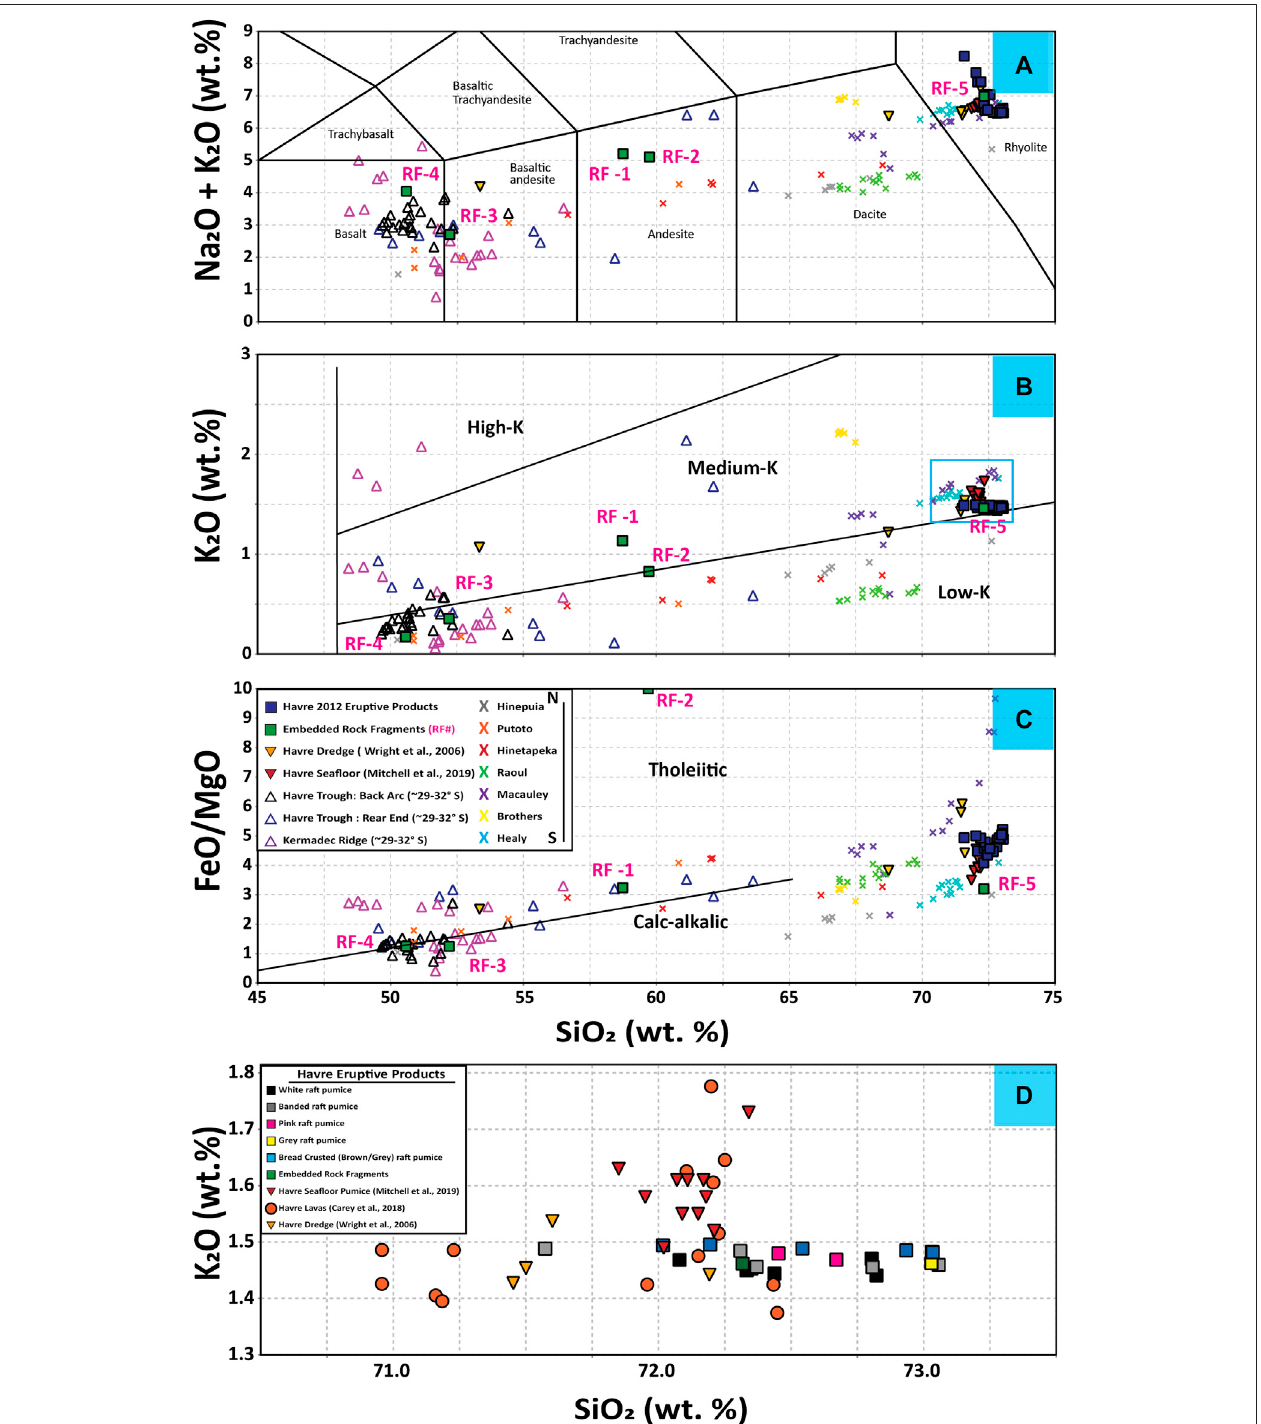
FIGURE 4 | Volcanic rock classi fi cation diagrams. (A) Total alkalis (Na 2 O + K 2 O wt%) versus SiO 2 wt% (TAS) diagram from Le Maitre (1989). (B) SiO 2 versus K 2 O with lines separating low-K, medium-K, and high-K boundaries (Gill, 1981). Note that the Havre 2012 eruptive products sit just above the low-K boundary near other rhyolites (e.g., Healy and Macauley) from the Kermadec Arc. The blue box outlines the area shown in panel (D) . (C) FeO/MgO versus SiO 2 where FeO is total Fe. The black line (SiO 2 = 6.4*(FeO/MgO) + 42.8) representstheboundaryforcalc-alkalineandtholeiiticmeltsfollowingtheclassi fi cationschemeofMiyashiro(1974).NotethattheHavrerhyoliteproductscannotbediscriminatedas eithertholeiiticorcalc-alkaline.Datapresentedherecollectedasapartofthisstudyareshownas fi lledsquares,withotherdatafromtheHavreeruptionareplottedas fi lledupside-down trianglesfromtheHavre2012sea fl oorpumice(red;Mitchelletal.,2019)anddredgesamplesthatpre-datedtheHavre2012eruption(gold;Wrightetal.,2006).Additionaldredgesamples collectedbetween~29and32 ° SfromtheHavreTroughback-arcandrearendarcandKermadecRidgeareshownhereasopentrianglessourcedfromHaueffetal.(2021);https://doi. org/10.26022/IEDA/111723).TocompareothervolcanicproductsproducedintheKermadecArc,wepresentwhole-rockchemistryfromHinepuia,Putoto,Hinetapeka,andRaoulfrom Timm et al. (2012) and Macauley, Brothers, and Healy volcanoes from Barker et al. (2013). (D) SiO 2 versus K 2 O zoomed in on the rhyolite fi eld of Havre eruptive products.